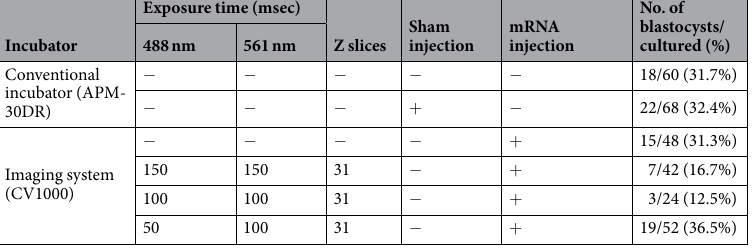
Table 1. Effects of live-cell imaging on bovine embryo